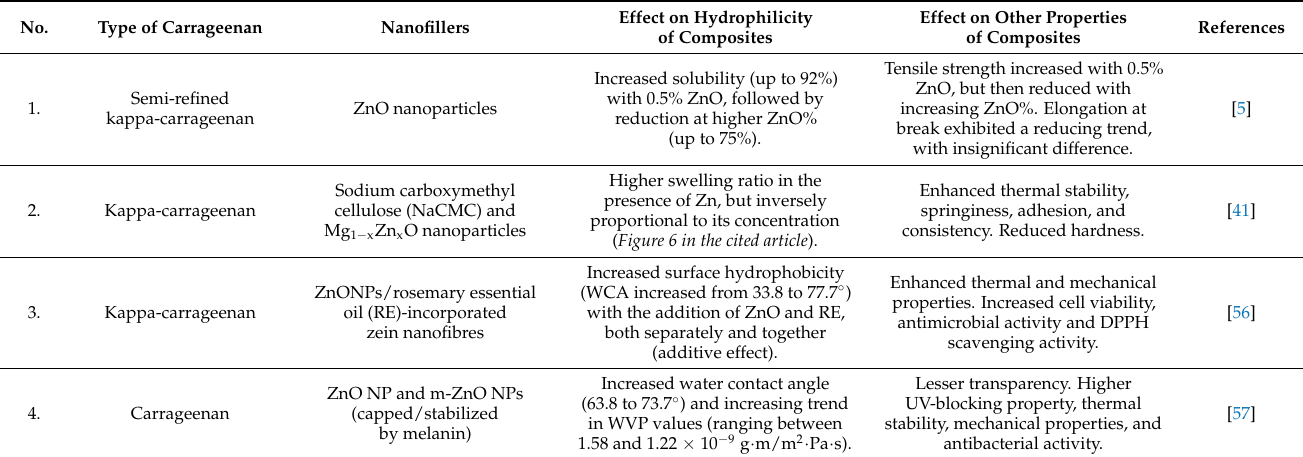
Table 5. Effect of refined vs. semi-refined carrageenan with ZnO